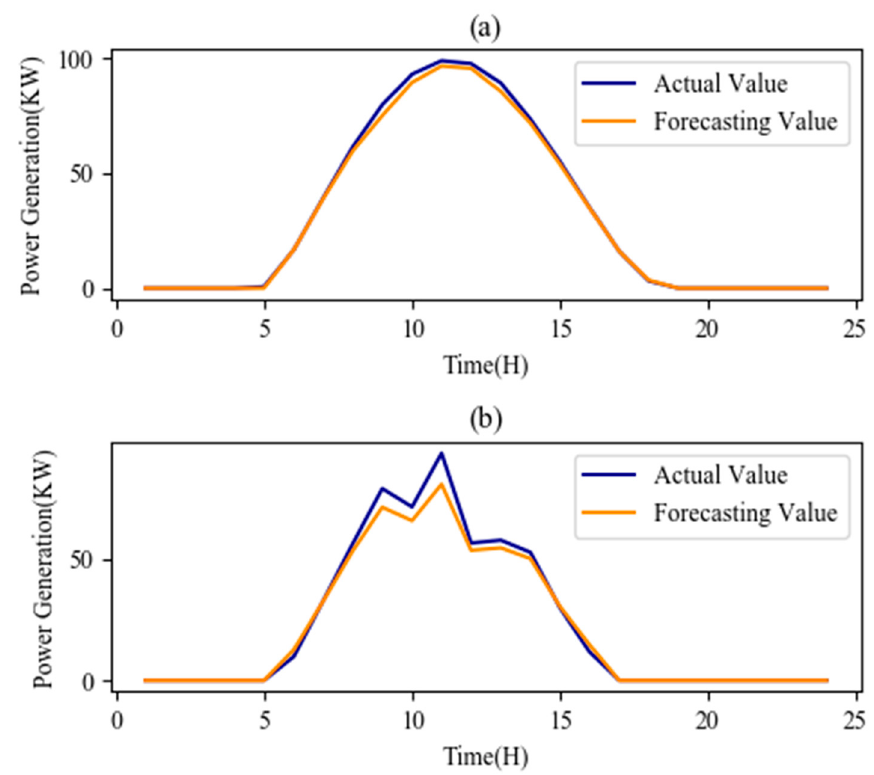
Figure 2. Solar power forecasting: ( a ) a sunny day; ( b ) a cloudy (rainy) day.